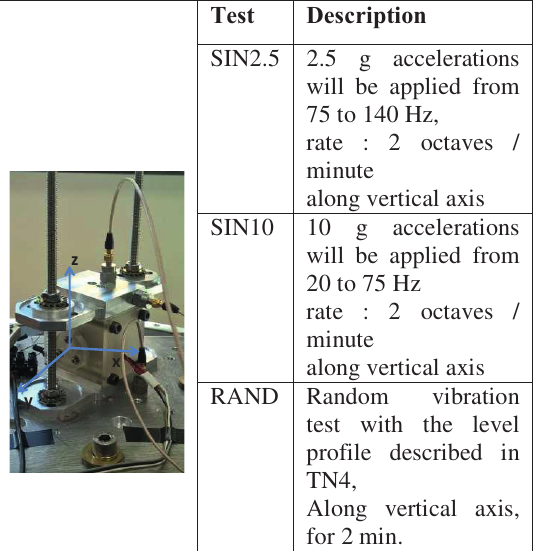
Fig. 3. GENUIN NesCOPO on the vibration pod and applied